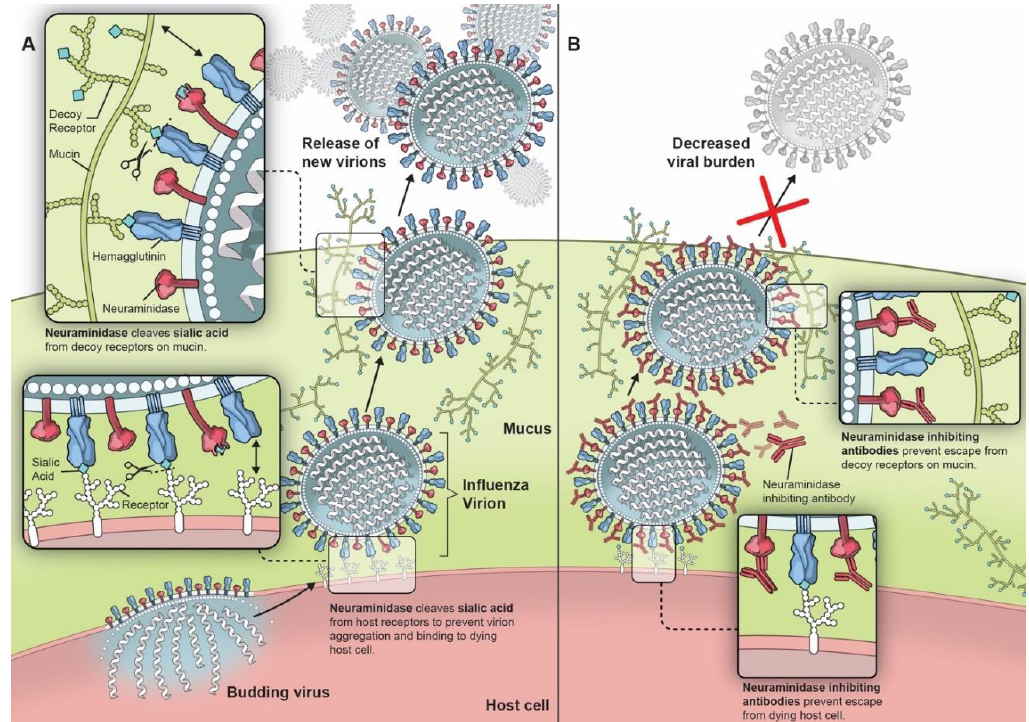
Figure 1. Importance of neuraminidase on influenza viral lifecycle ( A ) and the effect of neuraminidase inhibiting antibodies ( B ).